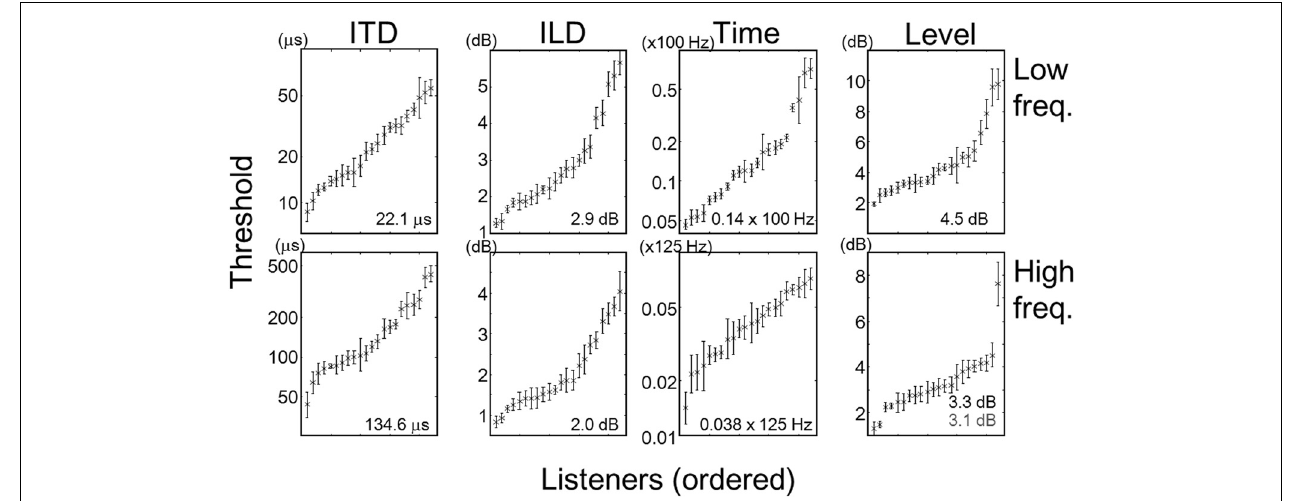
threshold. Note that for the ITD and Time tasks, the thresholds have been log-transformed. Numbers in the panel indicate the mean across the